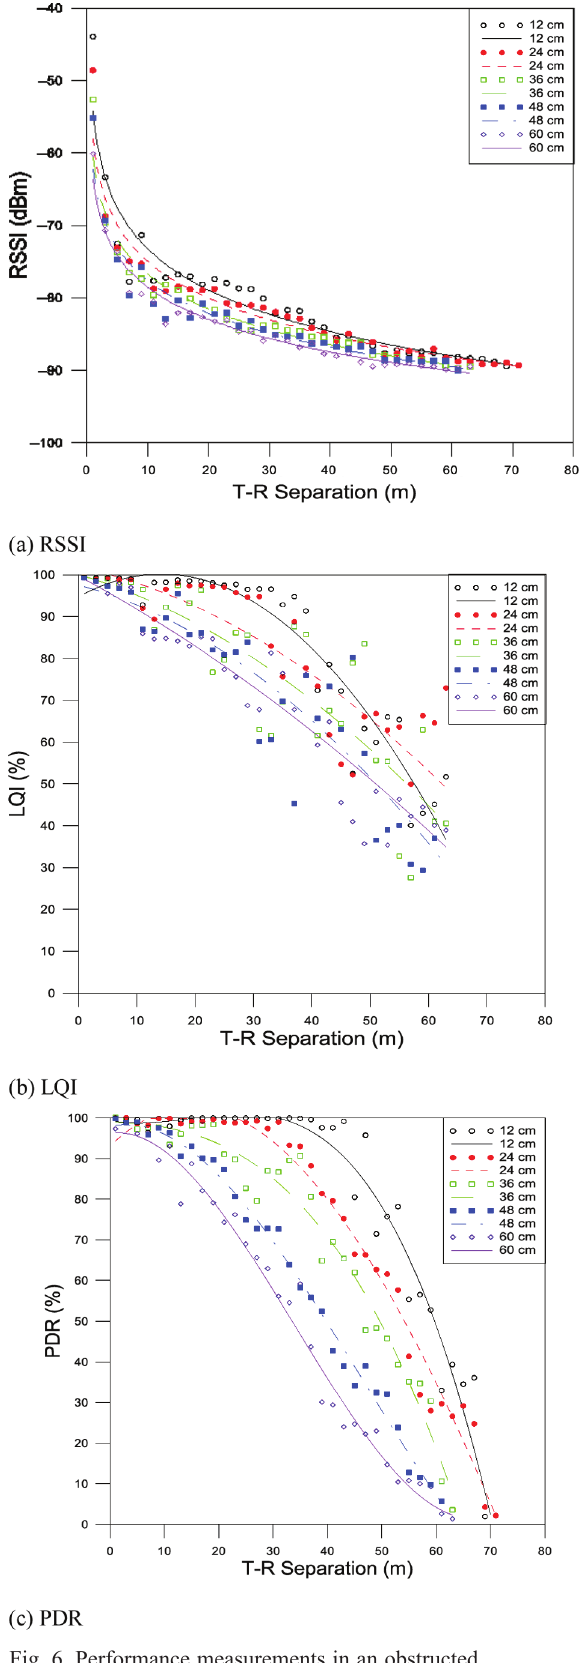
Fig. 6. Performance measurements in an obstructed environment (Concrete